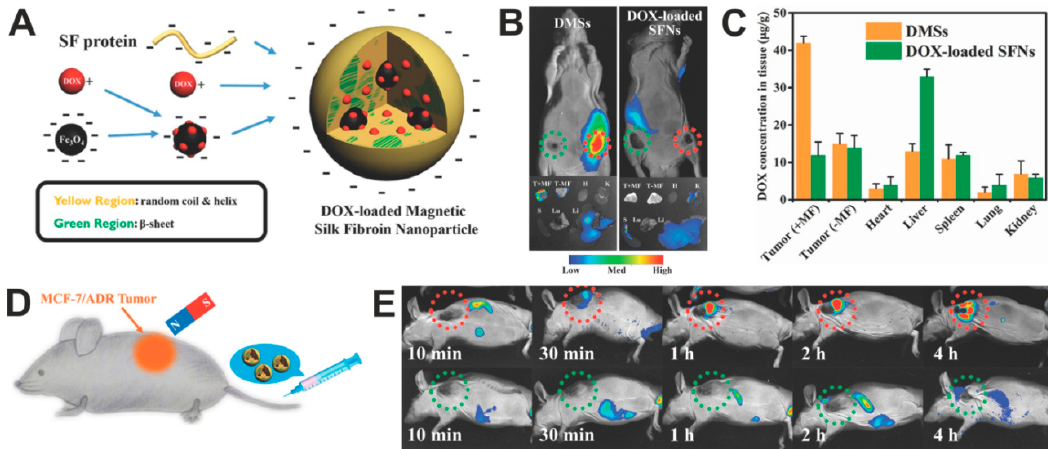
Figure 5. Doxorubicin-loaded magnetic silk fibroin nanoparticles (DMSs) in the targeted cancer treatment. ( A ) A scheme presenting the generation of DMSs: Dox is adsorbed in part on the surface of IONPs and then incorporated in the SF during the DMSs formation by using salting-out method. ( B ) Top panel: in vivo whole-body fluorescent imaging of MCF-7 breast cancer-bearing mice (tumors located on both sides) at 2 h after intravenous administration with DMSs or Dox-loaded SFNs; tumors location with and without magnet attachment are indicated with red and green circles, respectively. Bottom panel: tumors and major organs imaged ex vivo 12 h after intravenous administration of particles. ( C ) The biodistribution of the DMSs and Dox-loaded SFNs in the organs and tumors after particle administration and application of magnetic field at the tumor side; +MF and –MF: in the presence and absence of MF, respectively. ( D ) Schematic illustration of in vivo magnetic tumor targeting. ( E ) MCF-7/ADR tumors-bearing mice after injection of DMSs. DMSs contained 5 mg/kg of DOX. Reproduced with permission [140]. Copyright, 2014, Wiley.